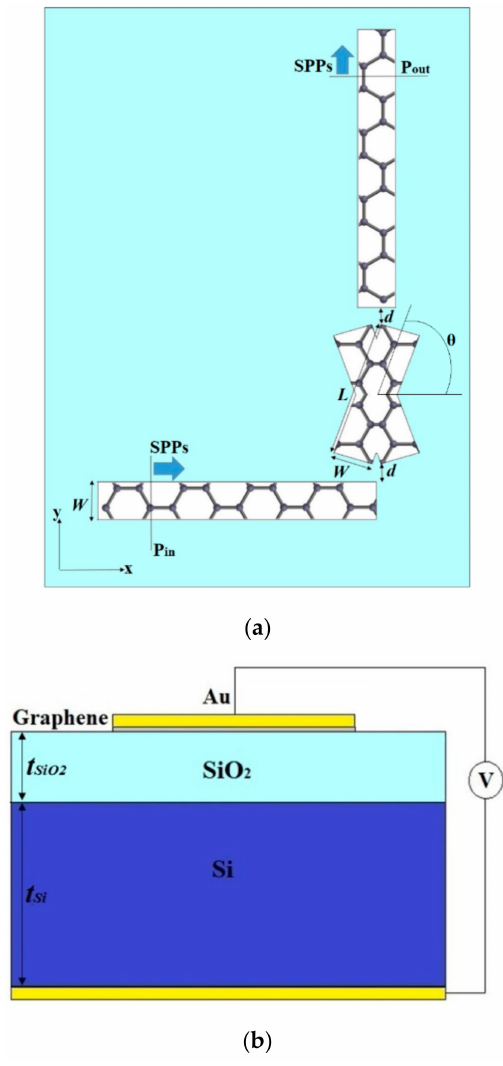
Figure 1. Two-dimensional (2D) ( a ) top and ( b ) side views of the MIR cross-shaped graphene plasmonic resonator. Two input / output graphene waveguides are coupled by a graphene cross-shaped resonator. Table 1. Structural and material parameters of the proposed graphene plasmonic resonator of Figure 1. Parameter Label Value Resonator length L 90 nm Resonator width W 30 nm Angle between the ribbon and the horizontal line in the cross-shaped resonator θ 40 ◦ Distance between the input / output waveguide and the resonator d 10 nm Graphene Fermi energy Ef 0.8 eV Thickness of SiO2 tSiO2 50 nm Thickness of Si Refractive index of SiO2 2.1 Refractive index of Si nSi